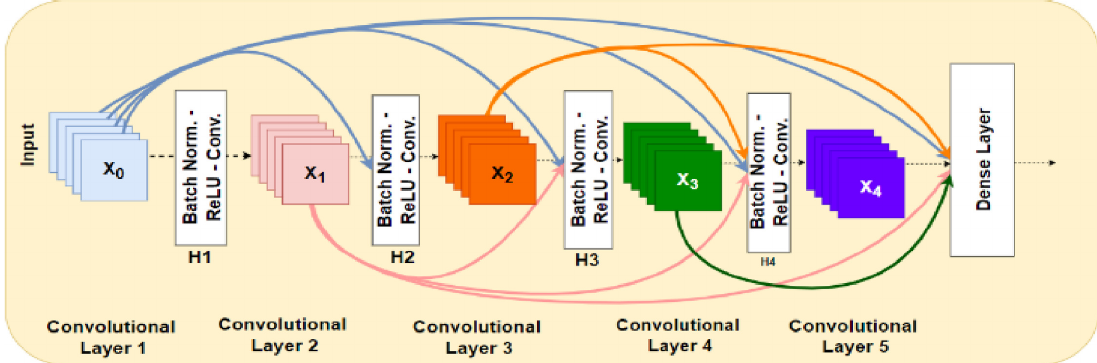
Figure 1. DenseNet architecture consisting of five concatenated convolutional layers.